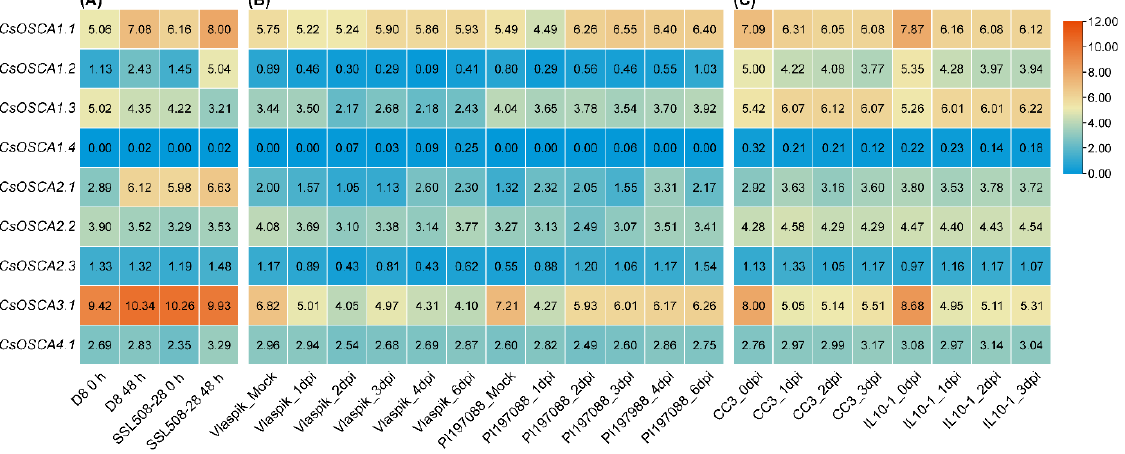
Figure 7. Expression profiles of CsOSCA genes under three biotic stress treatments including PM ( A ), DM ( B ), and RKN ( C ). ( A ) Expression analysis of CsOSCA genes in D8 (PM susceptible) and SSL508-28 (PM resistant) cucumber plants with and without inoculation of Sphaerotheca fuliginea . ( B ) Expression analysis of CsOSCA genes in Vlaspik (DM susceptible) and PI 197,088 (DM resistant) cucumber plants with and without inoculation of Pseudoperonospora cubensis . ( C ) Expression analysis of CsOSCA genes in CC3 (RKN-susceptible) and IL10-1 (RKN resistant) cucumber plants with and without inoculation of Meloidogyne incognita . dpi, day post inoculation.